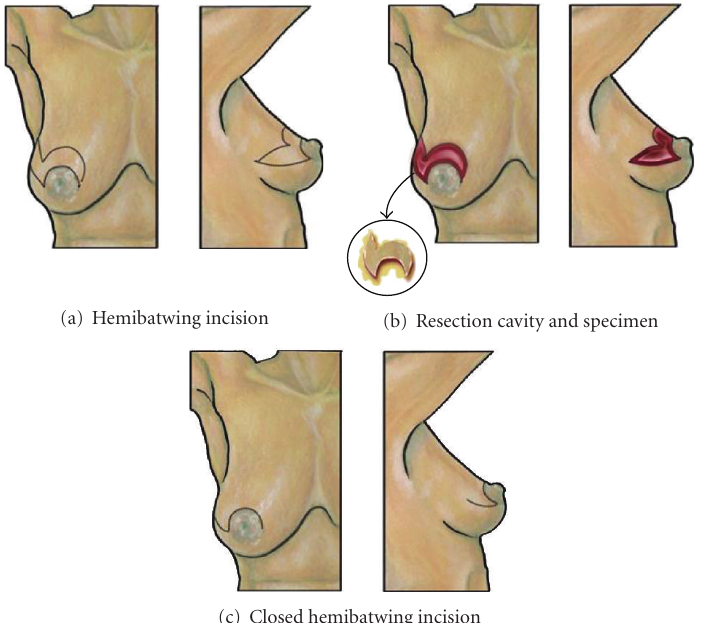
Figure 6: Hemibatwing resection. (a) Shows location of hemibatwing skin incision. (b) Shows resection cavity of hemibatwing resection with excised specimen (inset). (c) Shows breast following closure of the hemibatwing